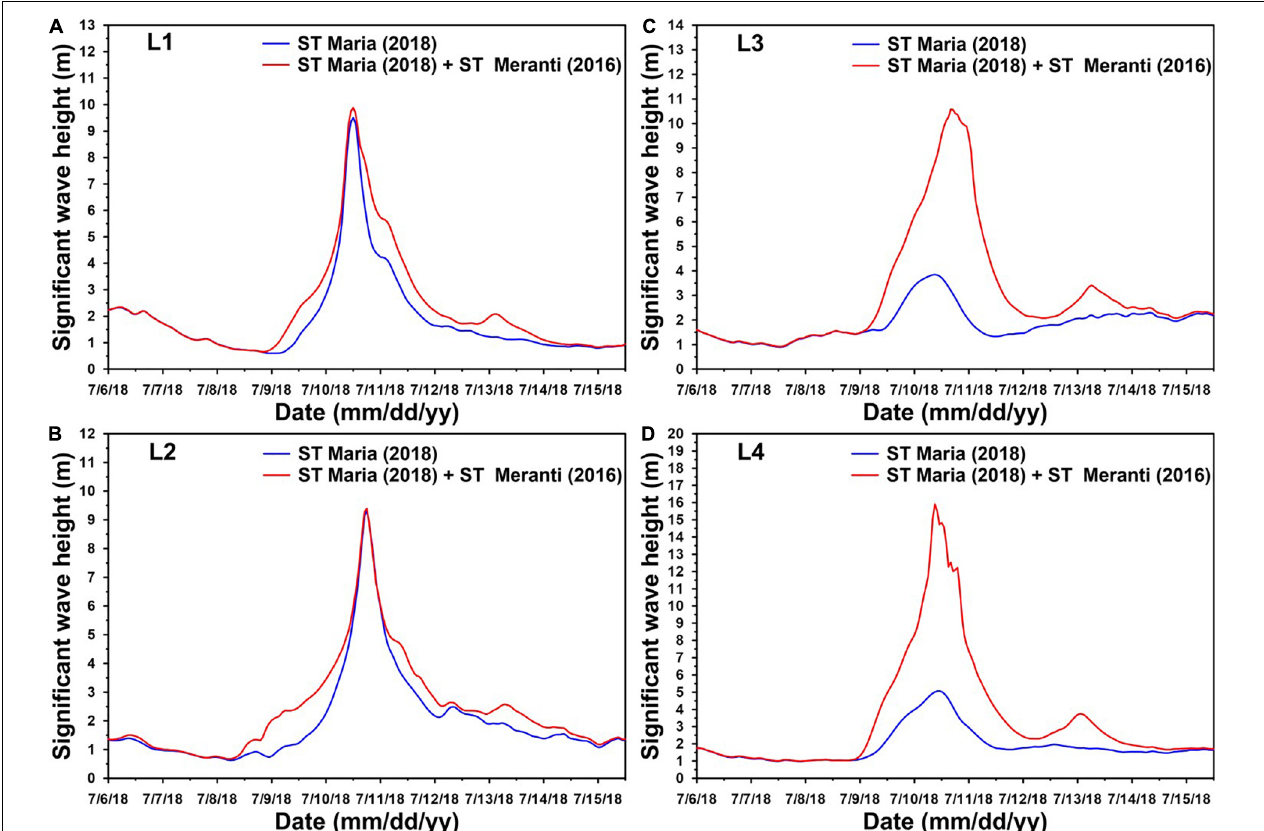
FIGURE 7 | Comparison of significant wave height time series generated by Super Typhoon Maria in 2018 and designed binary typhoons Maria (2018) and Meranti (2016) at (A) L1, (B) L2, (C) L3, and (D) L4 four selected representative points.